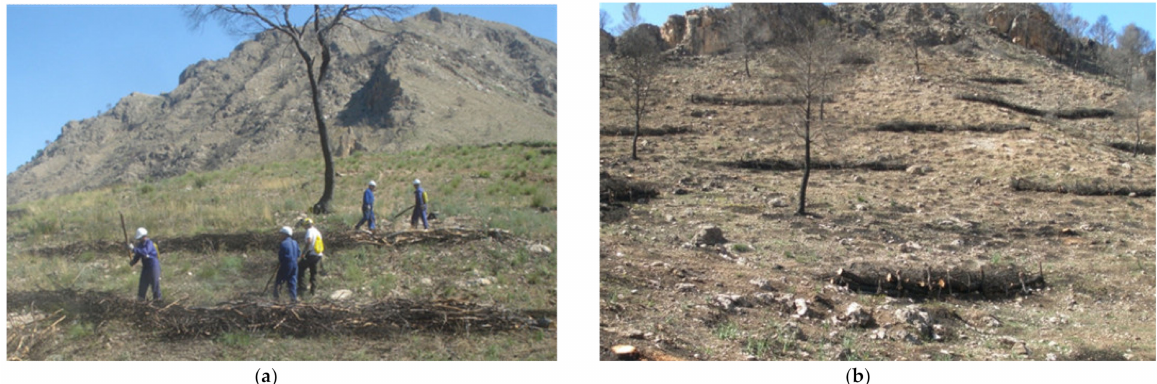
Figure 3. Photos of the construction of contour-felled log debris ( a ) and log erosion barriers ( b ) in Sierra de los Donceles forest (Castilla La Mancha,